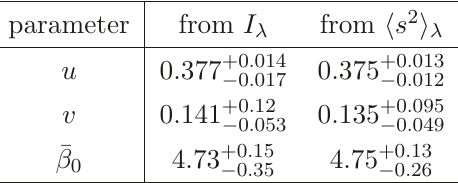
Table 3 . Results for ¯ β 0 , u , and v obtained with a constrained fit of λ c (¯ β ), obtained from I λ (left) and s 2 (right), with the function eq. (4.8), using m max = h i λ